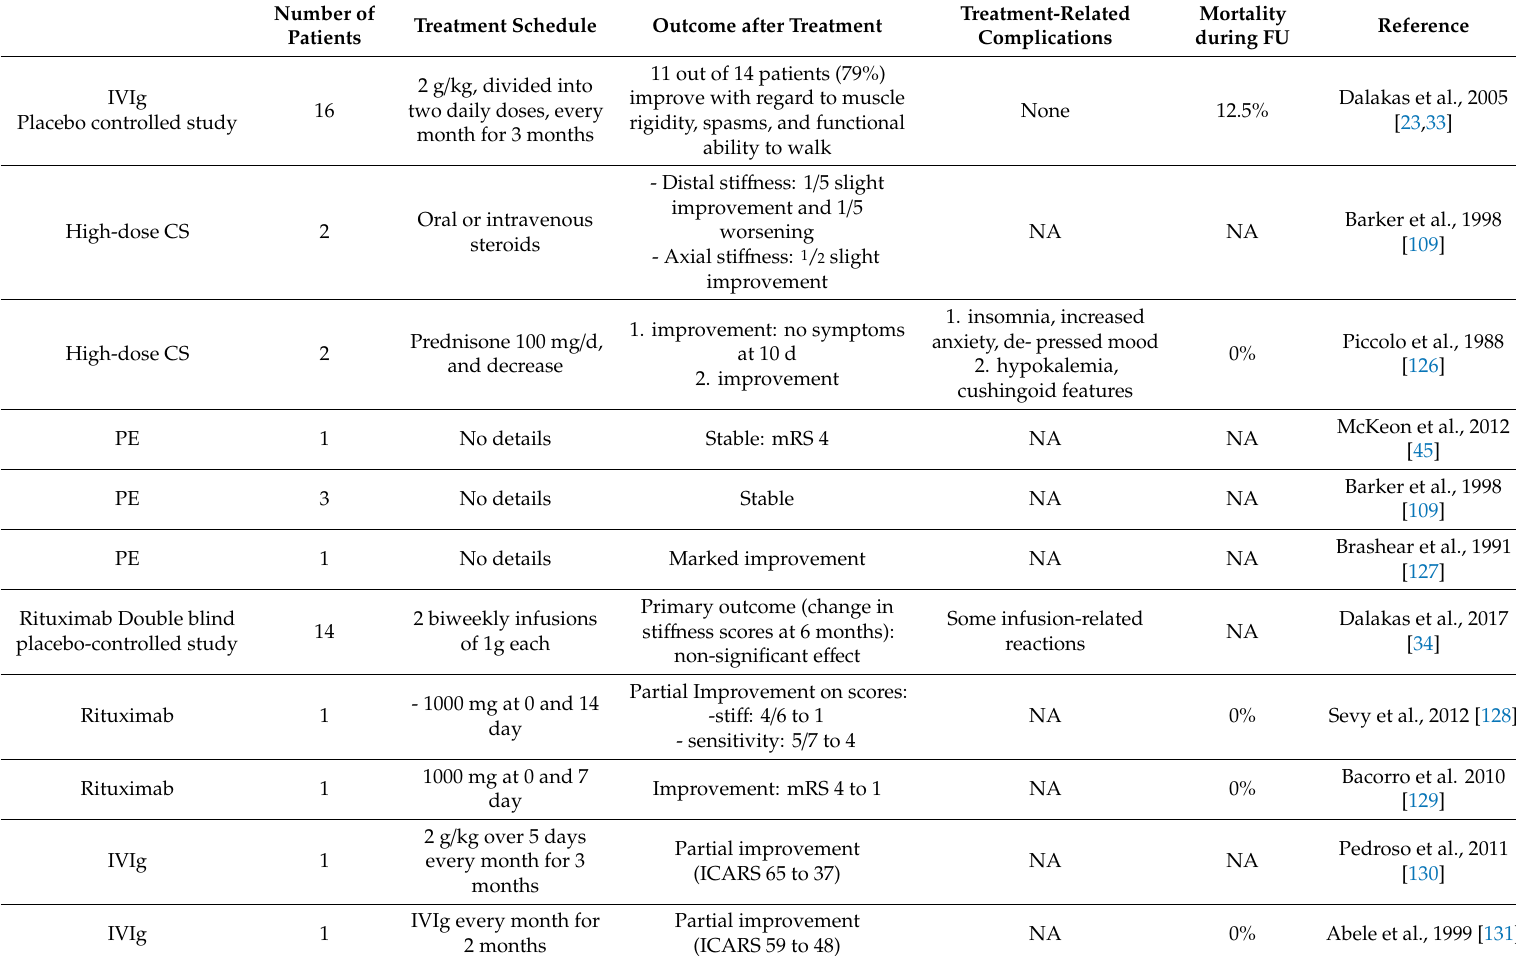
Table 2. Response to di ff erent immunotherapies in the main series of SPS, cerebellar ataxia, and limbic encephalitis associated with GAD Ab reported in